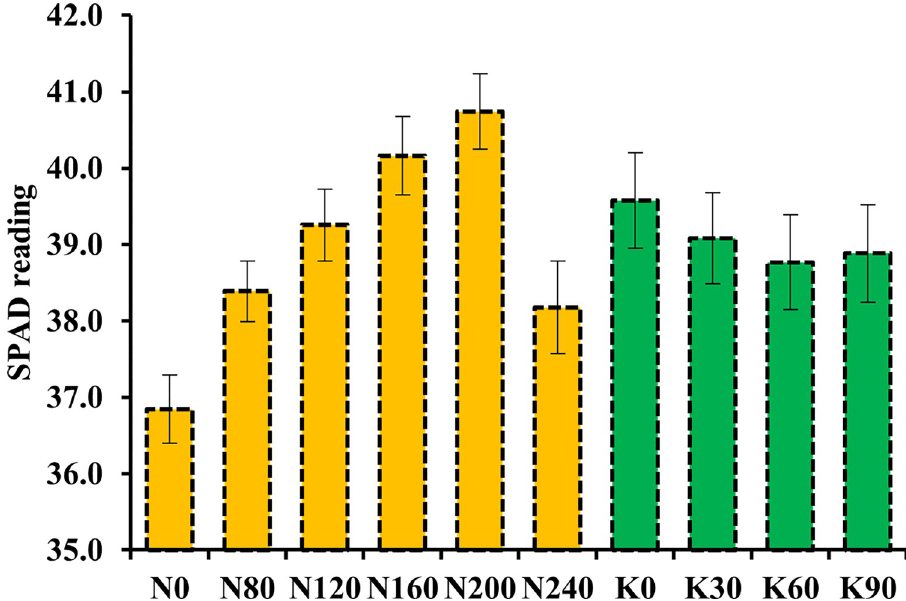
Fig 3. Effect of nitrogen (N) and potassium (K) application on SPAD value of wheat ( Triticum aestivum L.) in a sandy loam soil in sub-tropical India. Bars indicate the standard error from mean (S . E . M ) .